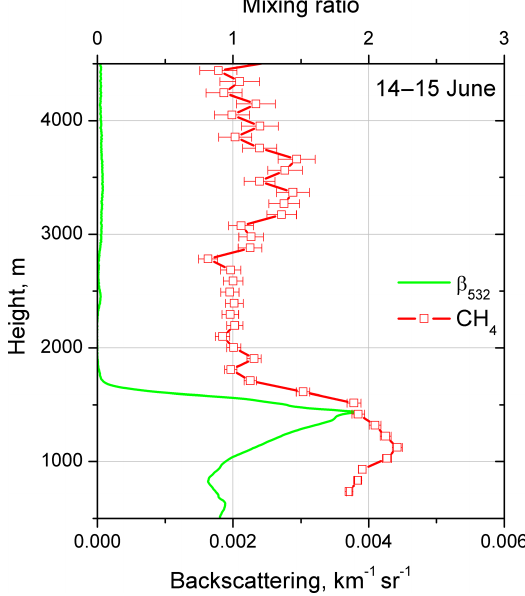
Figure 4. Vertical profiles of aerosol backscattering coefficient at 532nm and methane mixing ratio calculated from measurements on 14–15 June for the same temporal interval as in Fig. 3. Mixing ratio is uncalibrated and the value 1.0 corresponds to approximately